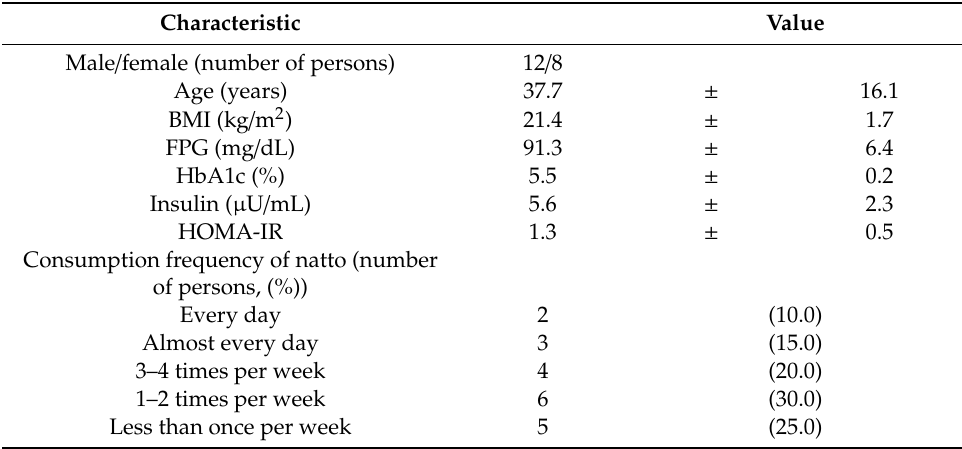
Table 2. Baseline characteristics of the